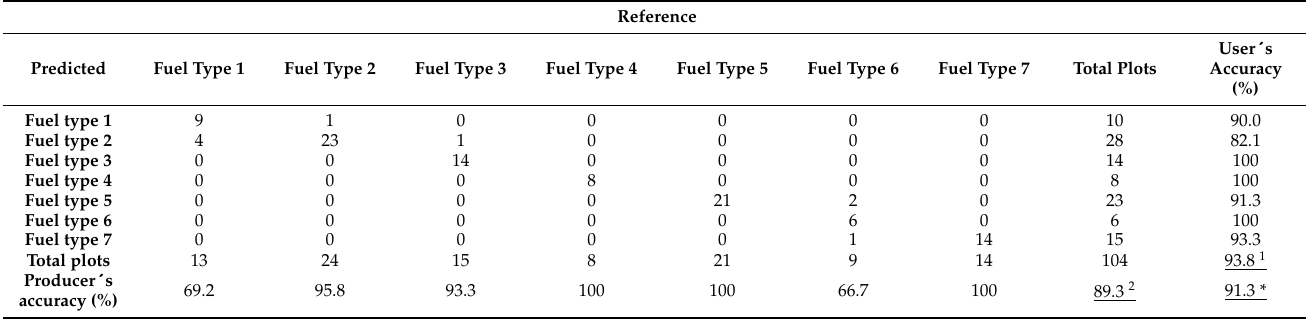
Table 11. Confusion matrix for the most accurate classification model after validation for year 2016. * Overall accuracy, 1 Mean user ´ s accuracy, 2 Mean producer